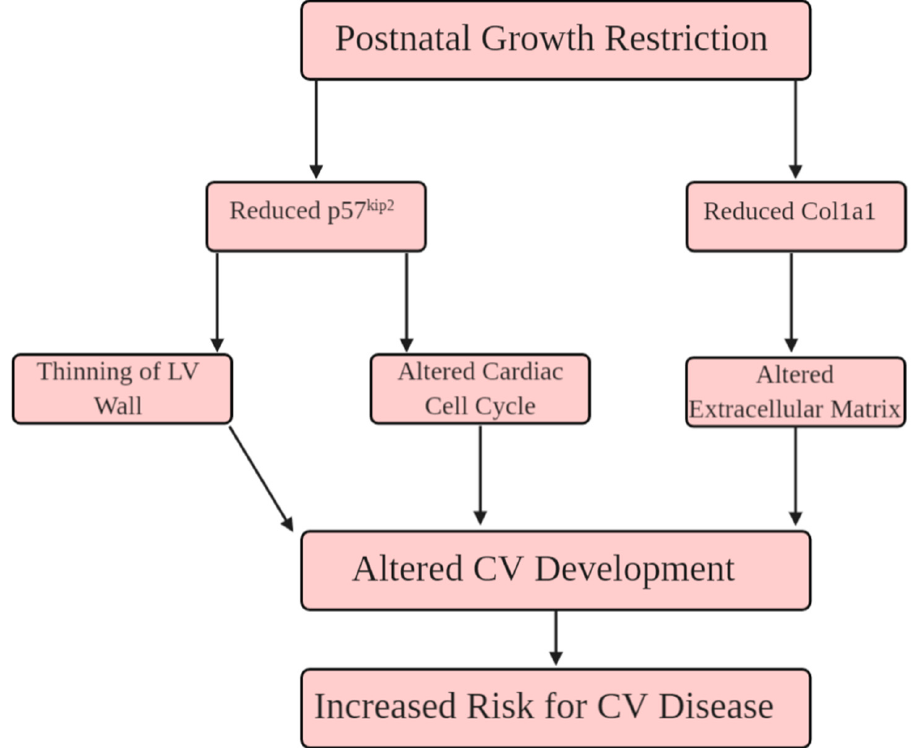
Figure 7. Hypothesized schema of how PGR alters extracellular matrix organization, and the cell cycle. (1) p57 kip2 is reduced during PN21, leading to impaired cardiomyocyte maturation, and thinning of the left ventricular (LV) wall. (2) Reduced collagen fiber networks impair the extracellular matrix into adulthood. The convergence of these proteomic alterations in the PGR heart increase the risk for cardiovascular disease (CVD) in adulthood.